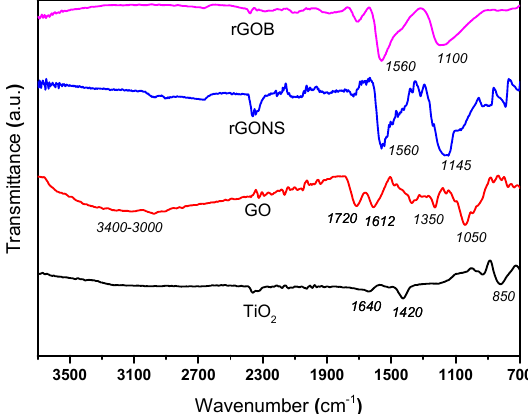
Figure 1. FT-IR spectra of TiO 2 (T), graphene oxide (GO), reduced graphene oxide nitrogen/sulphur (rGONS), and reduced graphene oxide boron (rGOB).